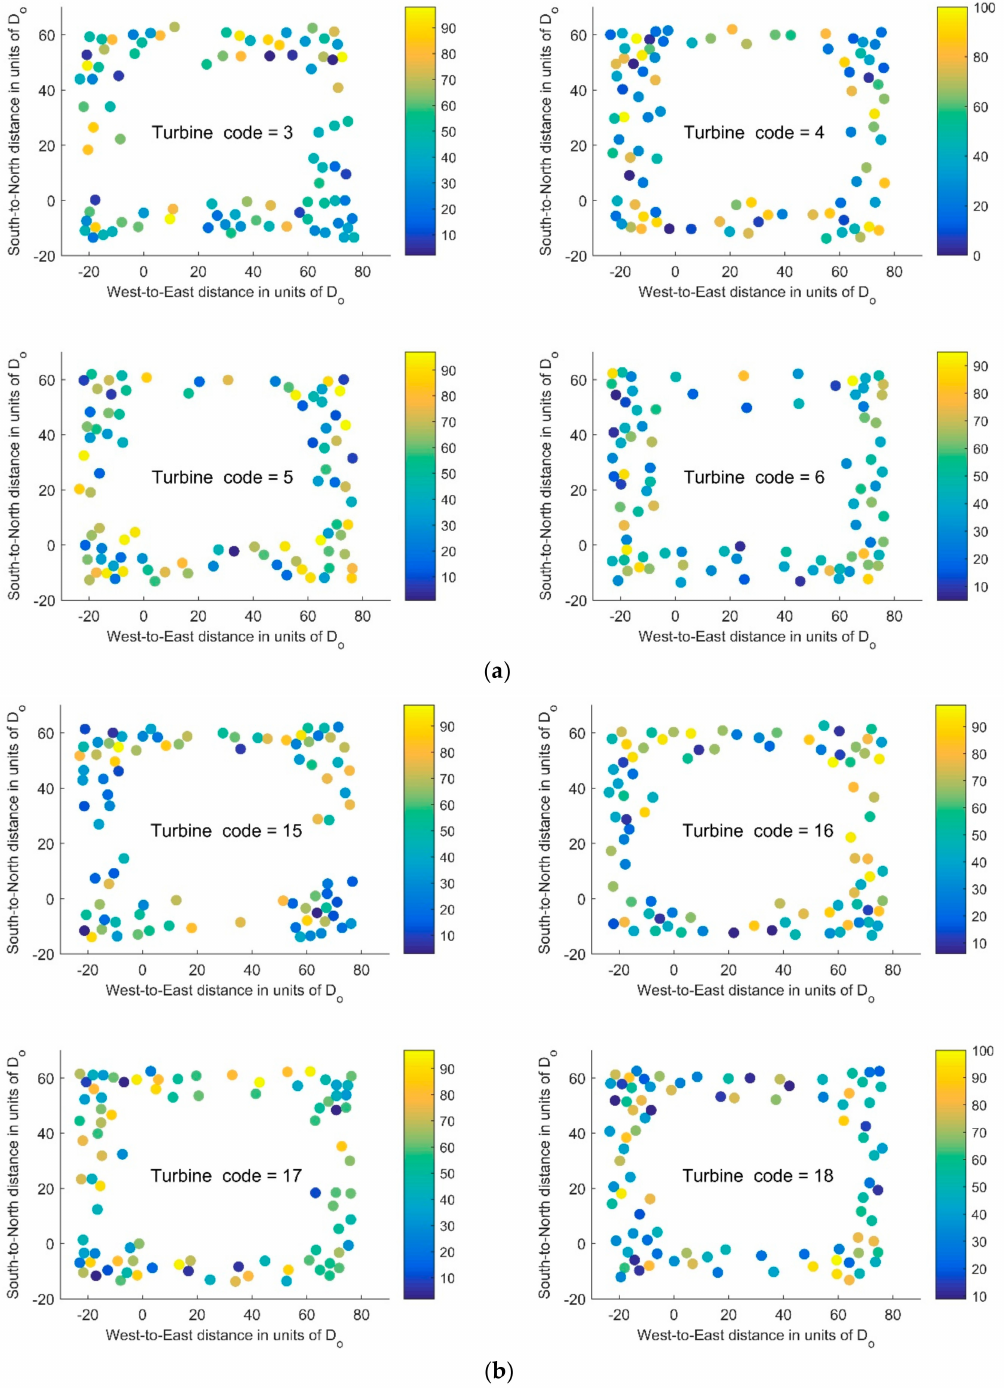
Figure 10. Turbine locations and C H values for selected unstructured cases. ( a ) Turbines 3–6 with P R = 2 MW; ( b ) Turbines 15–18 with P R = 3.45